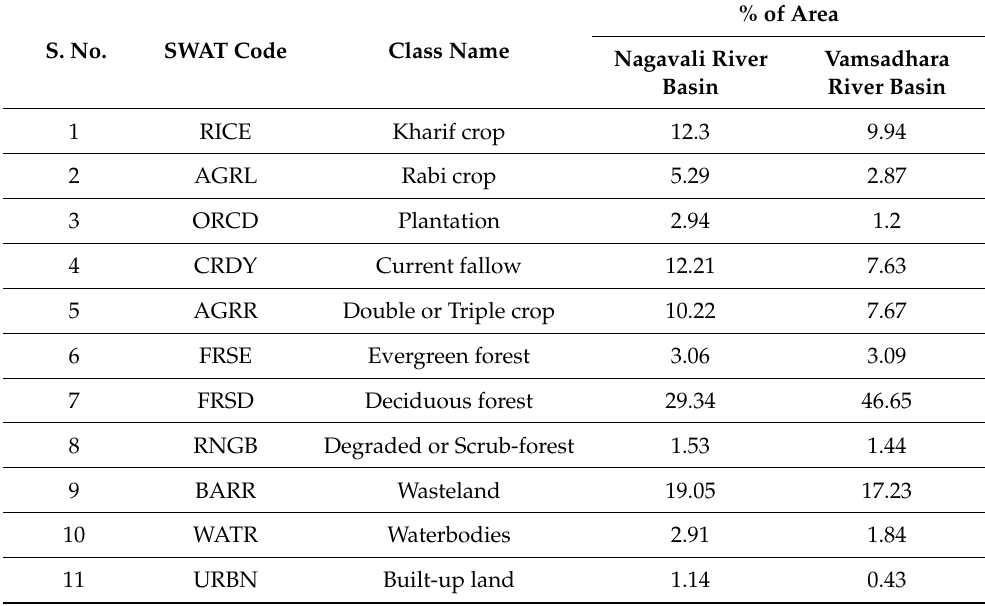
% of Area Nagavali River Vamsadhara Basin River